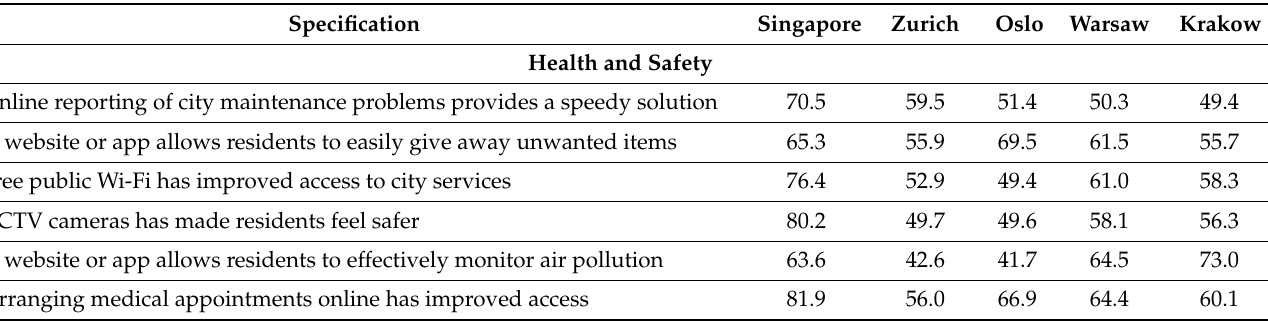
Table 3. A cumulative list of smart city scoring on the basis of the IMD-SUTD Smart City Index (SCI)—technological factors